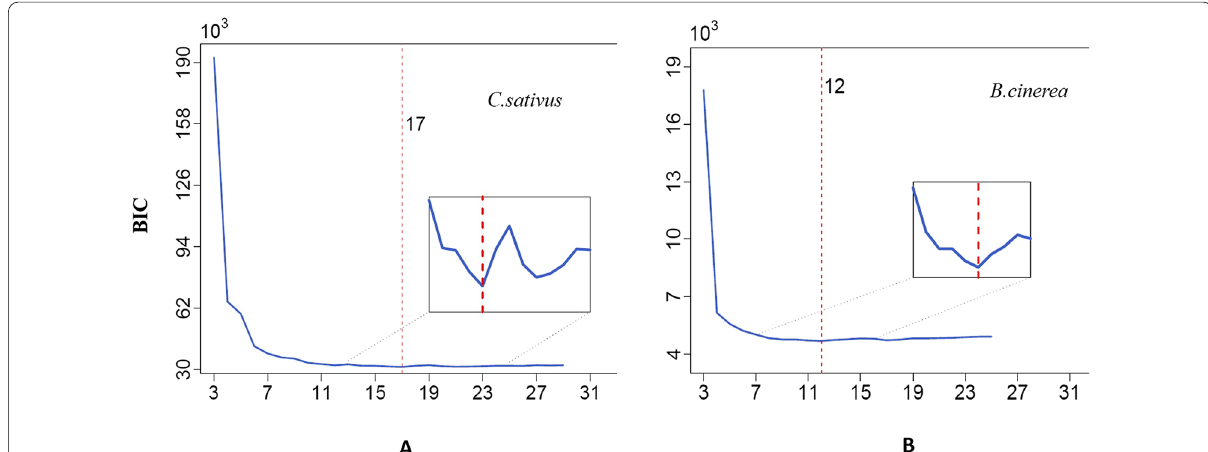
Fig. 1 Plot of BIC values over the number of groups calculated from the transcriptomic data. A C. sativus ; B B. cinerea